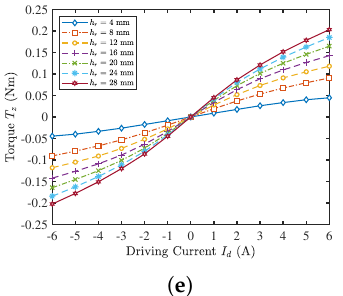
Figure 8. Three-dimensional FEM simulation results for different rotor heights h r . ( a ) Axial reluctance force for a rotor deflection in the z -direction. ( b ) Radial destabilizing force for a rotor deflection in the x -direction. ( c ) Restoring torque for a rotor tilting around the axis perpendicular to the direction of magnetization. ( d ) Active radial force for an applied suspension current. ( e ) Active torque for an applied drive current.